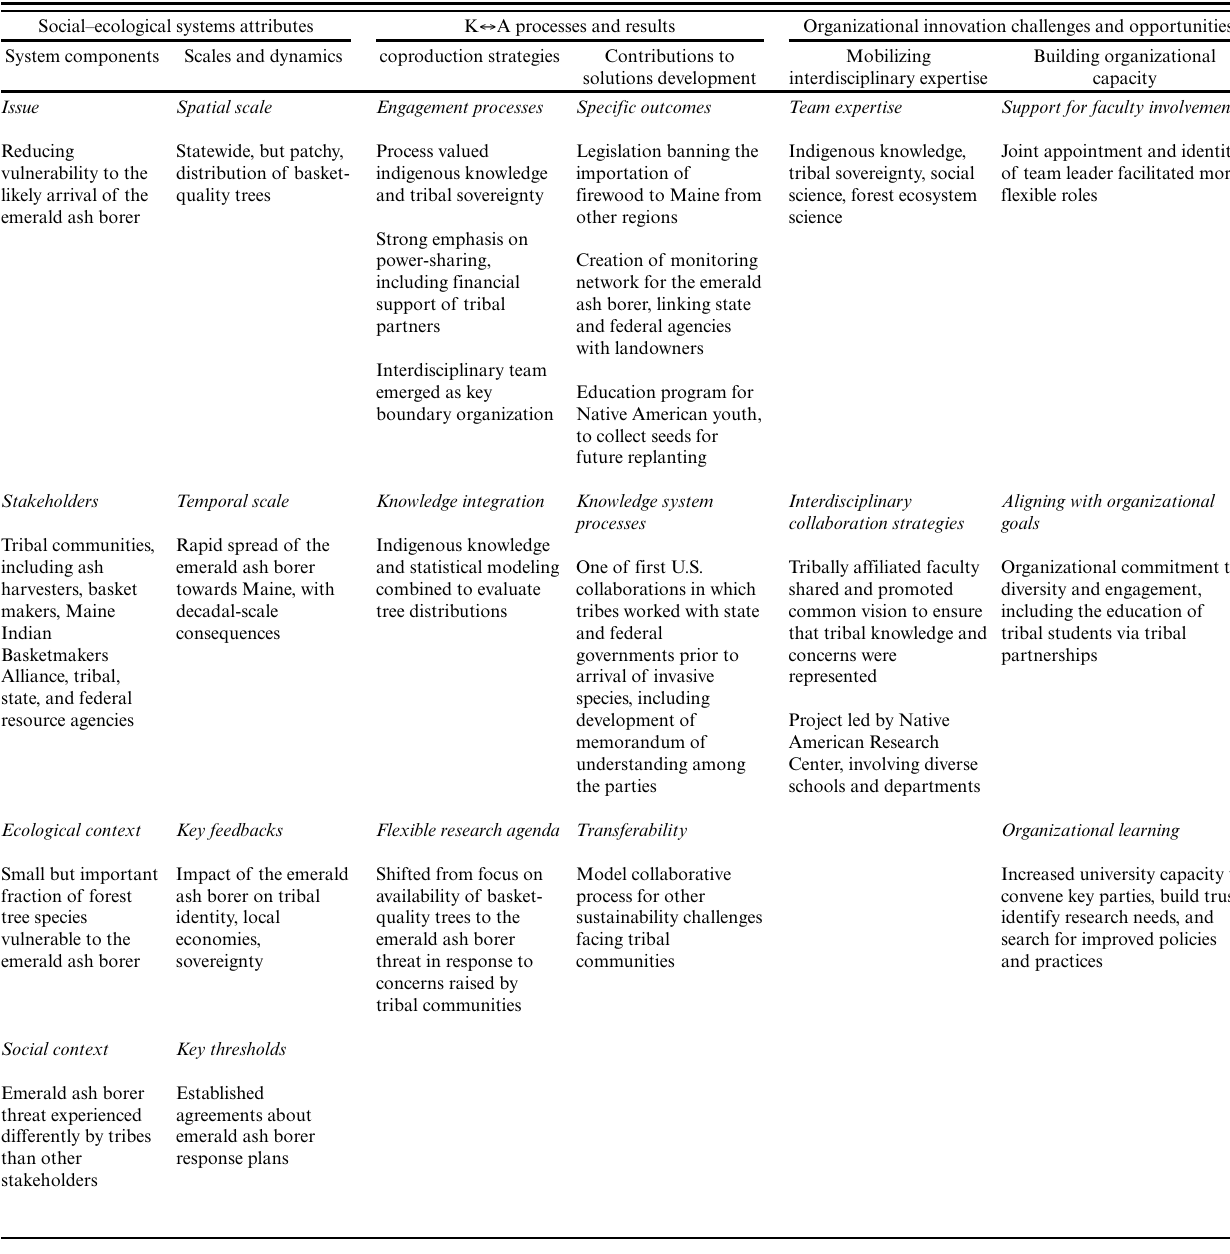
Table 3 . Major characteristics of three solutions-focused research projects: the emerald ash borer. Social–ecological systems